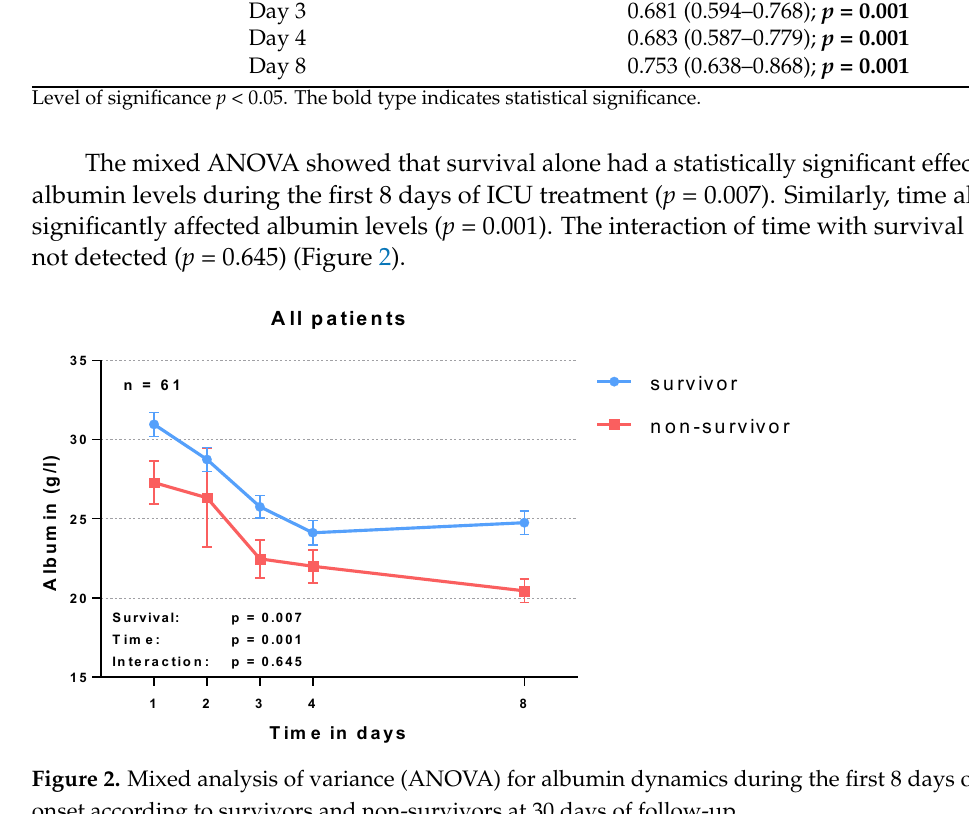
Figure 2. Mixed analysis of variance (ANOVA) for albumin dynamics during the first 8 days of SC onset according to survivors and non-survivors at 30 days of follow-up.